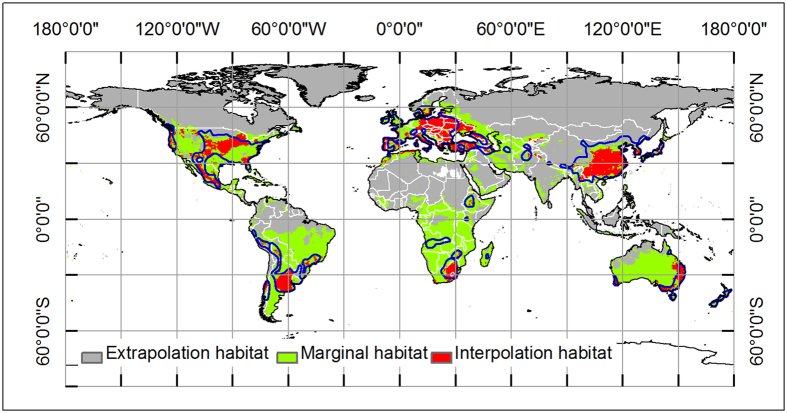
Multivariate environmental similarity surface (MESS) map of novel habitat, which is produced by MaxEnt v3.3 (http://www.cs.princeton.edu/~schapire/maxent/).Coarse blue polygon represents potential distribution range of oriental arborvitae using threshold of 0.2. Red color represents interpolation habitat (positive value), green color represents marginal habitat (near zero), and grey color represents extrapolation habitat (negative value). The whole map is generated by using the tool of ArcGIS 9.3 (ESRI, Redlands, CA, USA, http://www.esri.com/).